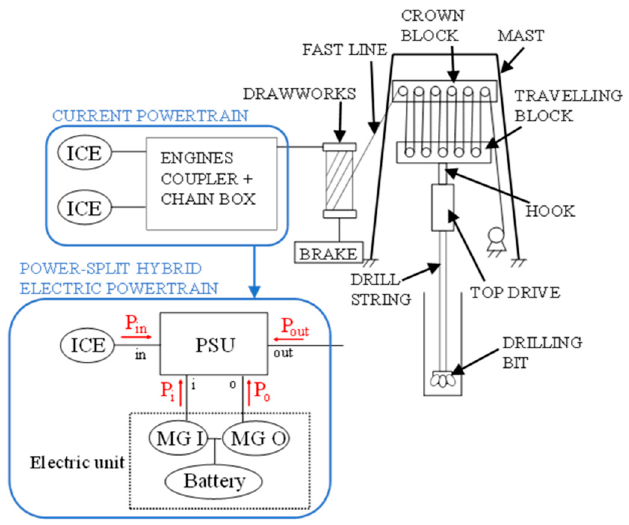
Figure 1. Drillmec MR-8000 hoisting system and drawworks prime movers before and after hybridization. Red arrows show the PSU power positive sign.